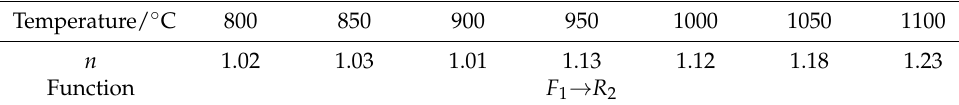
Table 5. Avrami–Erofeev exponent n at 800–1100 ◦ C for